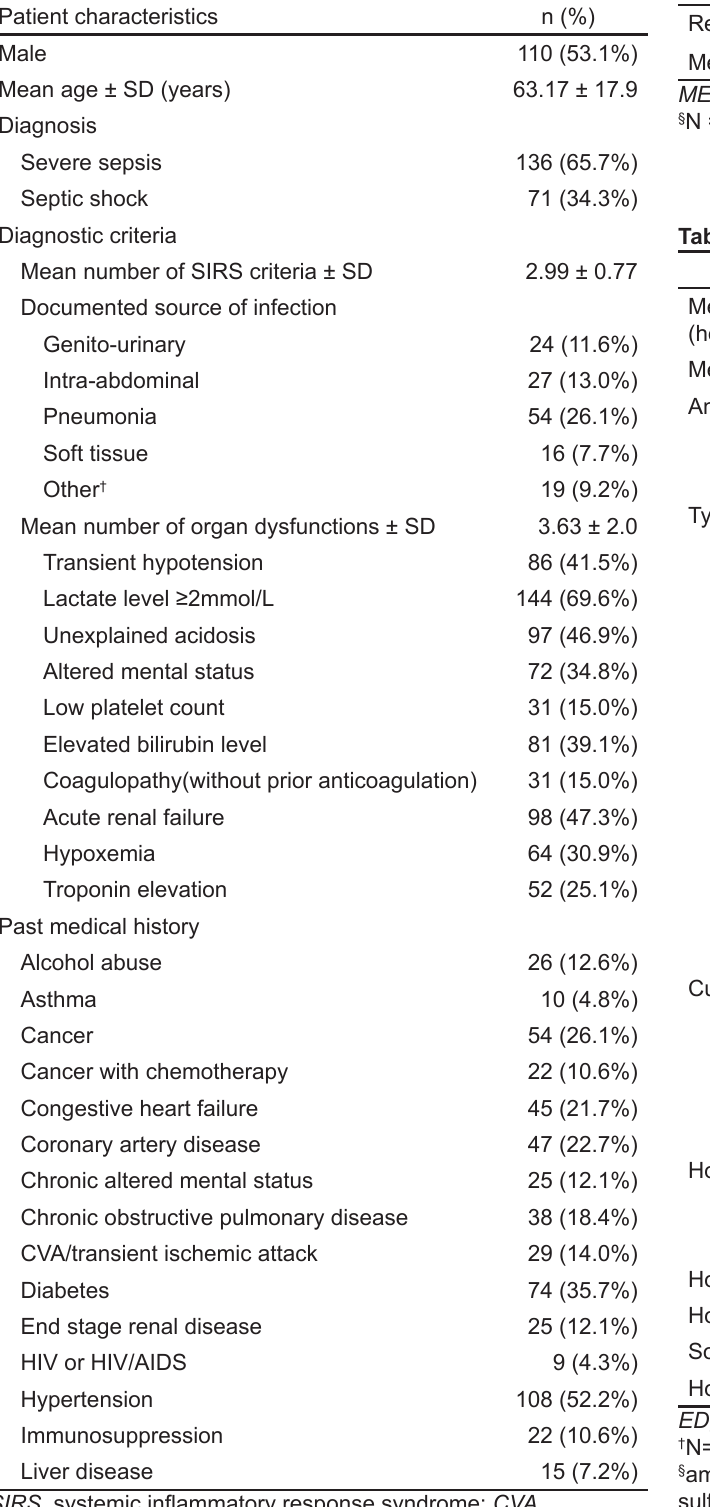
Table 1. Patient characteristics (n=207) in study of lactate clearance as predictor of survival in patients with severe sepsis.